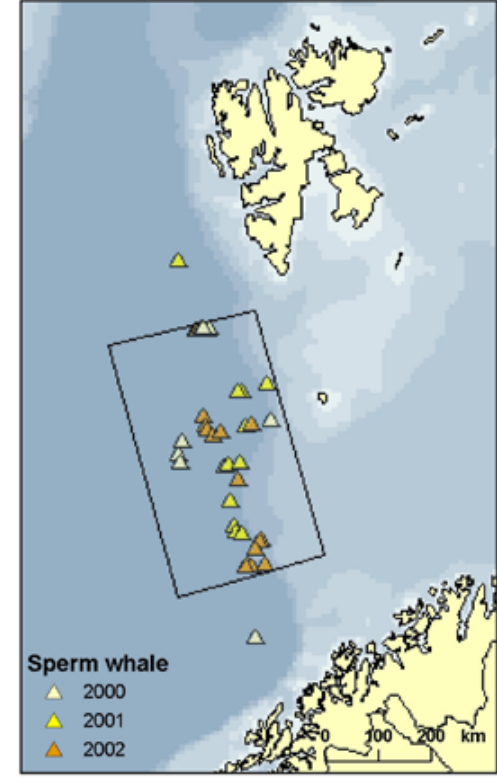
Fig. 11. Distribution of sperm whales in 2000, 2001 and 2002. Polygon enclosing the defined sperm whale core area is